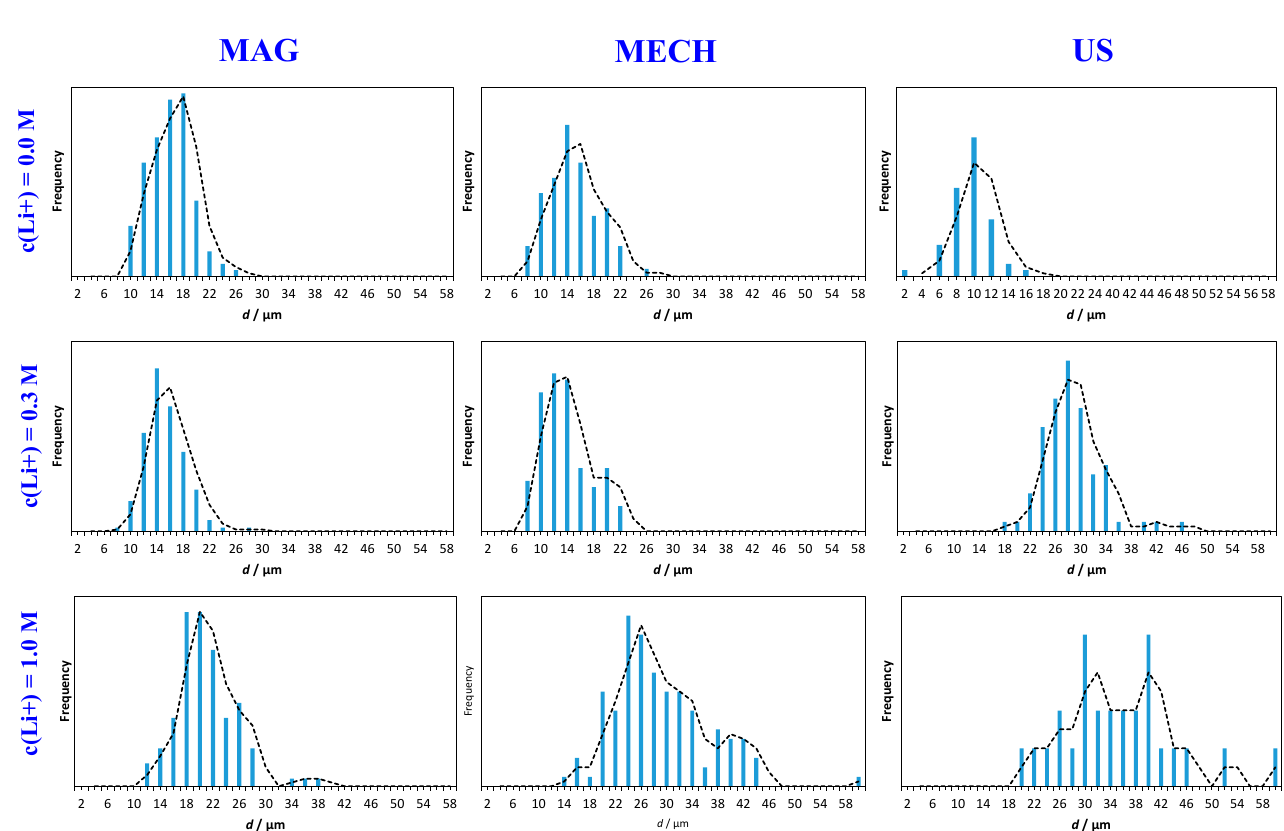
Figure 2. Particle size distribution of calcite crystals obtained after 5 days in the systems with different stirring modes (MECH—mechanical stirring, MAG—magnetic stirring, US—ultrasonic stirring) and initial Li + concentrations. Distributions were determined by using ImageJ.